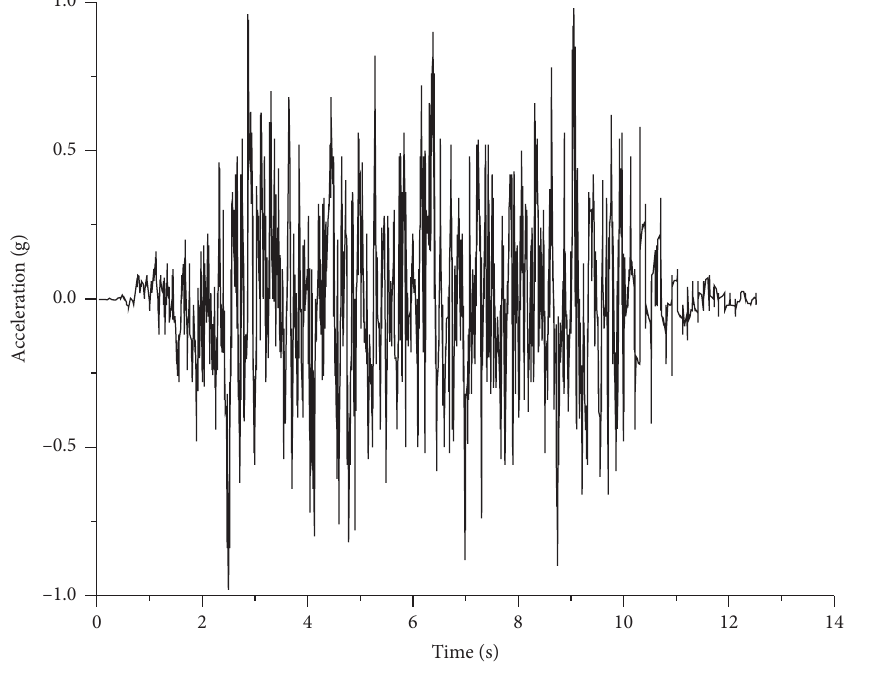
Figure 5: Seismic wave three: artifcial seismic wave. Table 1: Seismic wave parameters adjustment